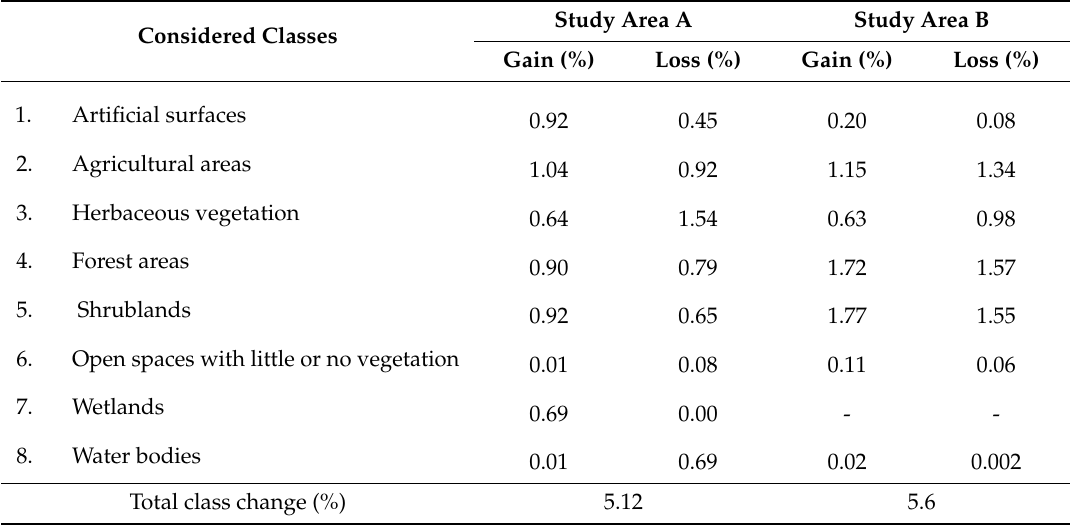
Table 5. Variation of classes’ area between the maps resulting from the conversion of COS 2015 and COS 2018 to the classes used in this study.